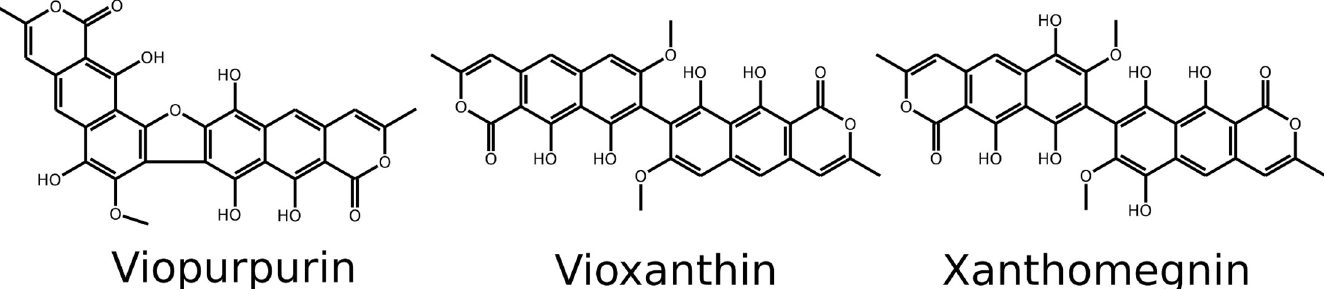
Fig 4. Chemical structures of Xanthomegnin (PubChem CID: 3032411), Viopurpurin (#73759973) and Vioxanthin (#119072), the three main pigments of T . rubrum . These compounds give T . rubrum the characteristic red pigmentation. They are belong to the family of 1,4-naphthoquinone and are synthesized from polyketides. The structural data of Xanthomegnin (PubChem CID: 3032411), Viopurpurin (#73759973) and Vioxanthin (#119072) were downloaded from NCBI PubChem database as xml file. Afterwards the files were converted with the Linux Babel software to pdb files, converted with Gnome GChemPaint software to a svg vector graphic and arranged with GNU program Inkscape.